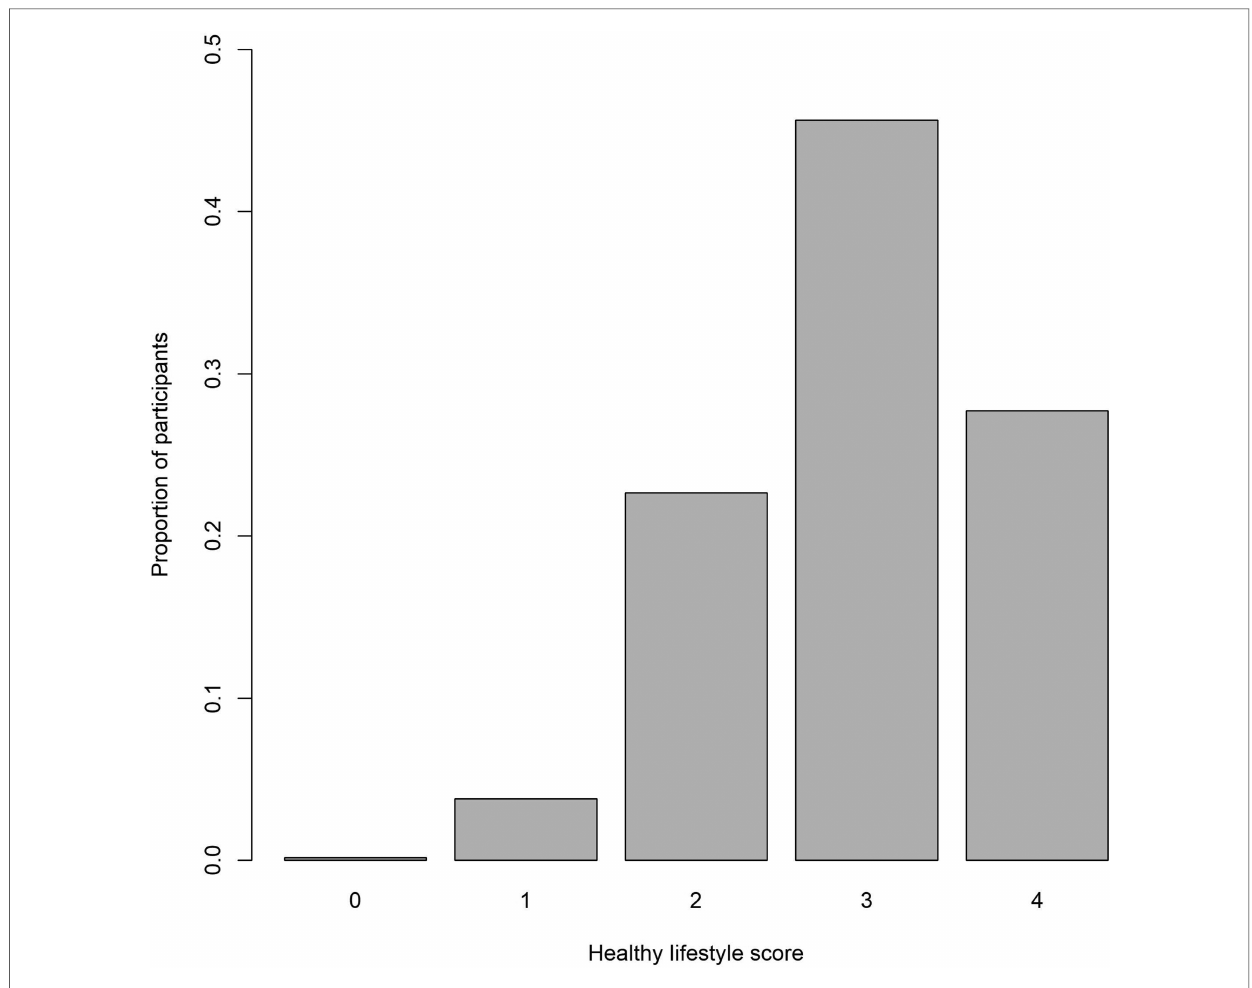
FIGURE 1 Association of predicted ECG-age with chronological